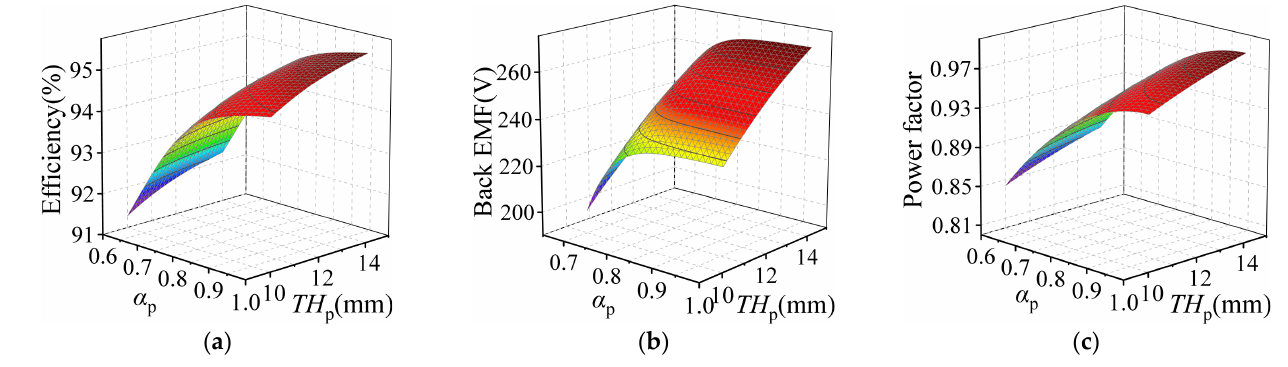
Figure 6. Response surface of pole arc coefficient and PM thickness to electromagnetic performance parameters. ( a ) Efficiency; ( b ) back EMF; ( c ) power factor.